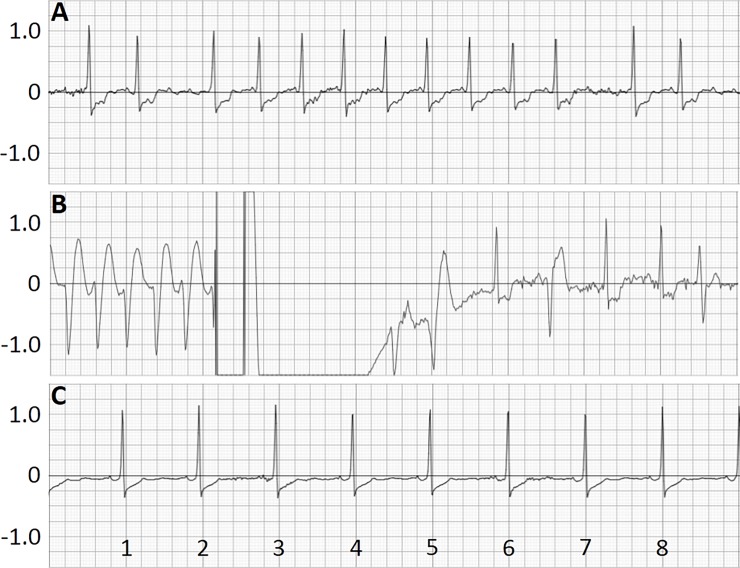
Electrocardiogram showing 9 seconds of data recorded by the WCD side-to-side channel electrodes.(A) Heart rhythm recorded by the WCD 4 days prior to VT. (B) Shock (150J) delivered by the WCD in response to sustained VT and recovery of sinus rhythm. (C) Heart rhythm recorded 7 days after delivery of shock. Recording speed (x-axis) is 25mm/second and amplitude scale (y-axis) is 1mv/20mm. Elapsed time (seconds) following the beginning of the recording are indicated.